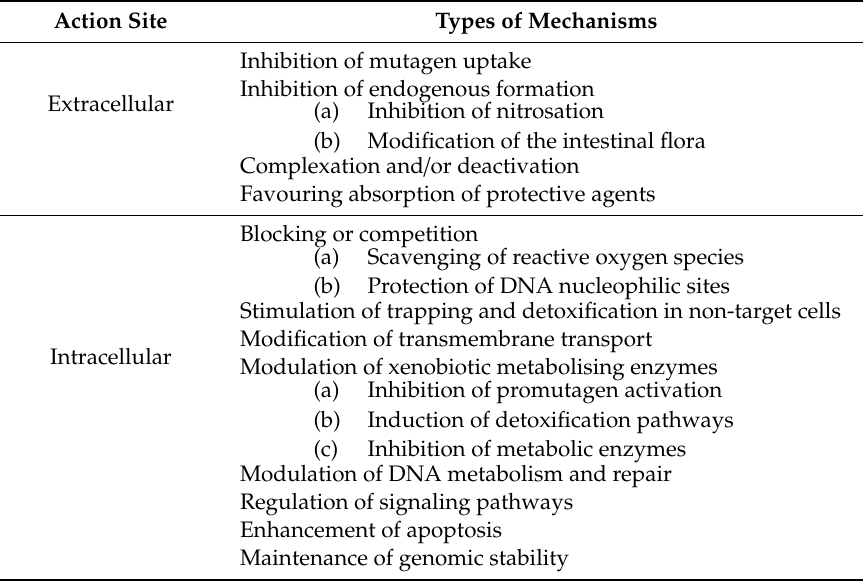
Table 1. Main mechanisms of antigenotoxic